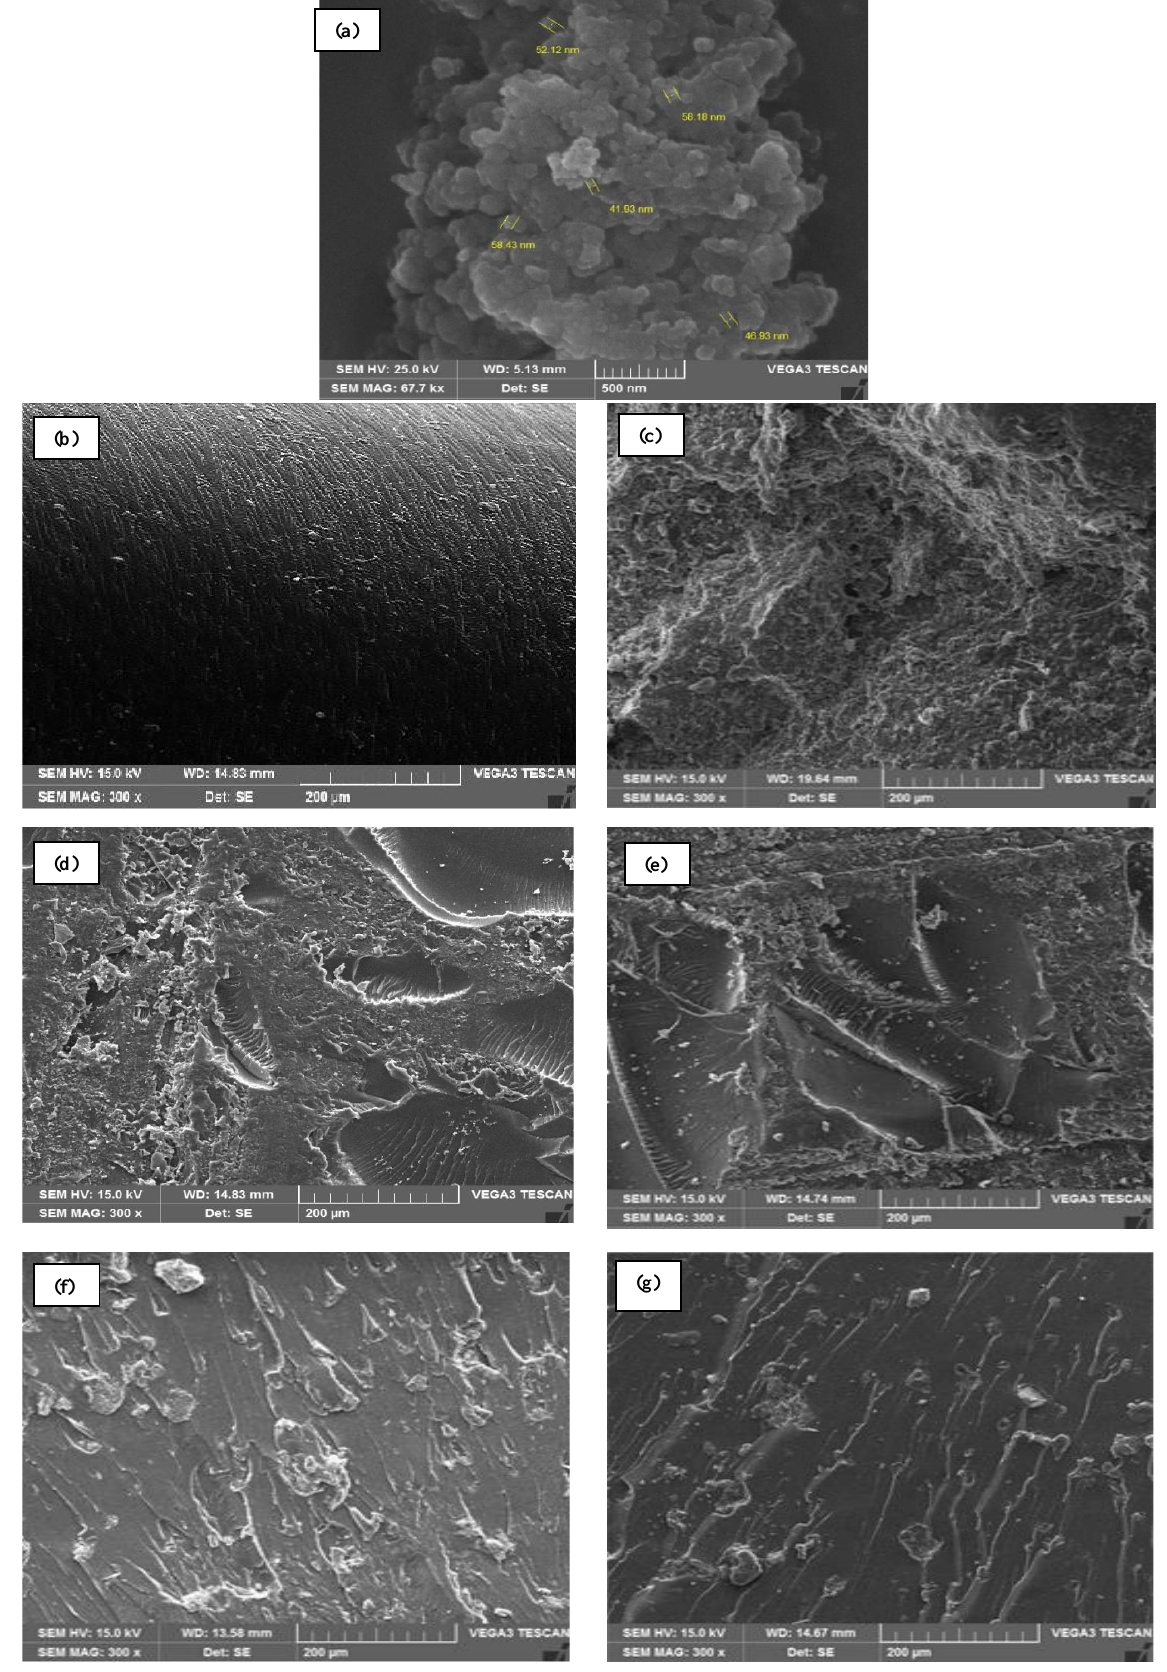
Fig. 3. SEM images of (a) TiO 2 powder and various concentrations of TiO 2 nanofiller (b) Pure Epoxy (c) 0.5 (d) 1.0 (e) 1.5 (f) 2.0 and (g) 2.5 %wt. of nanoTiO 2 -epoxy